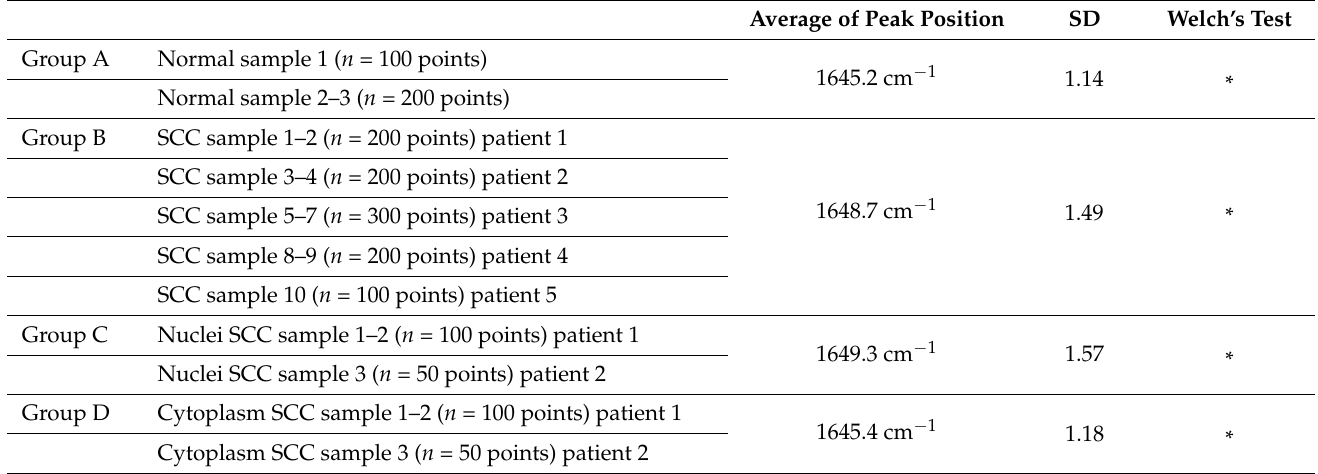
Table 1. Peak position of amide I in the SCC and normal areas, and in the nuclei and cytoplasm of SCC cells. Sample numbers and measurement points are indicated.